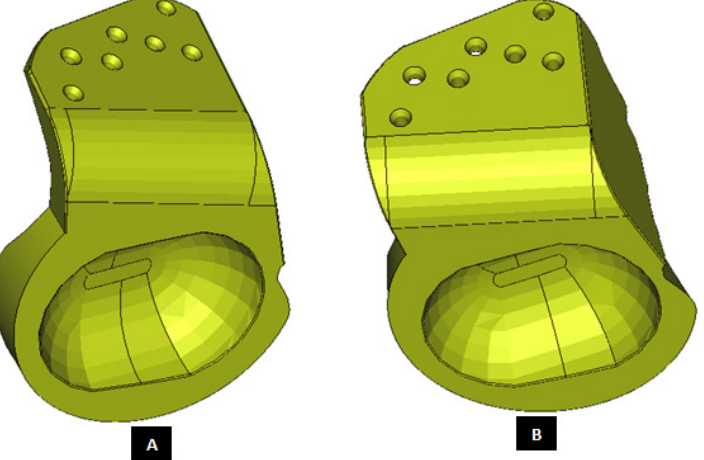
Figure 17. Patient-specific design of fossa prosthesis ( A , B ). The device has a rectangular grove (with curved anterior and posterior edges) in its inferior surface for articulation with condylar head. The uniquely designed articulating surface/hole is slanted in anterior direction. This anterior slope of articulating surface is intended to provide opportunity for anterior translation of the condylar head during movements of mandible. This feature of our fossa prostheses provides an advantage over currently available total TMJ implants which, when implanted, only rotate but do not translate during functional movements of the patient’s jaw